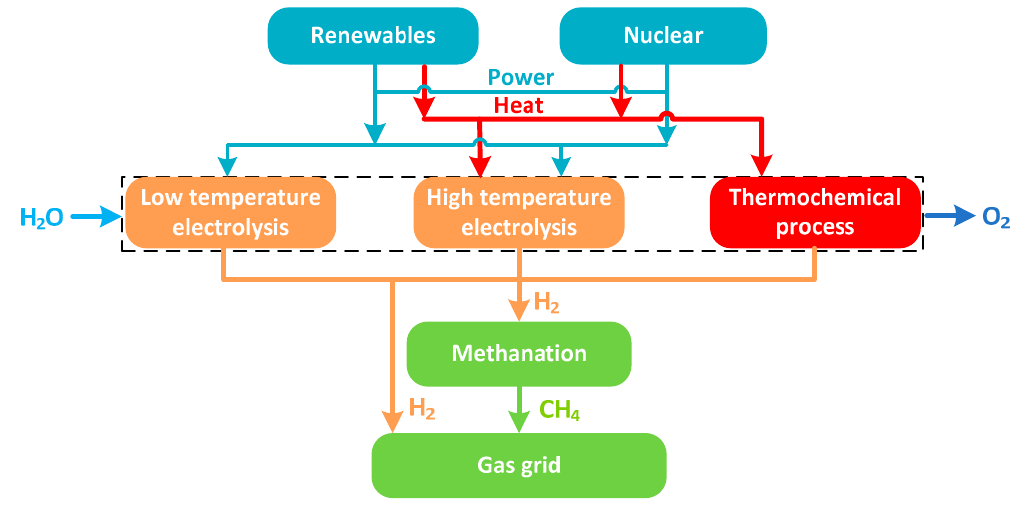
Figure 4. Conceptual hybrid renewable and nuclear power-based hydrogen and SNG production.